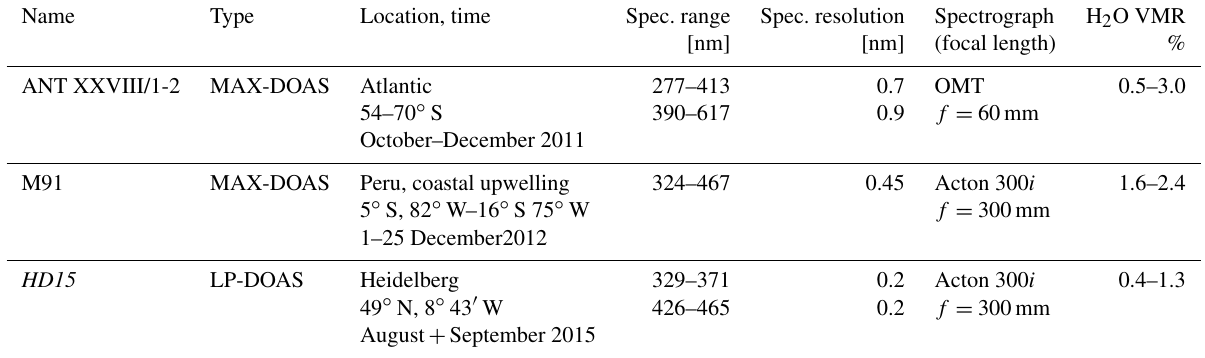
Table 1. Campaigns of which measurements were used. The cruise tracks of the shipborne MAX-DOAS measurements are shown in Fig. 2. Name